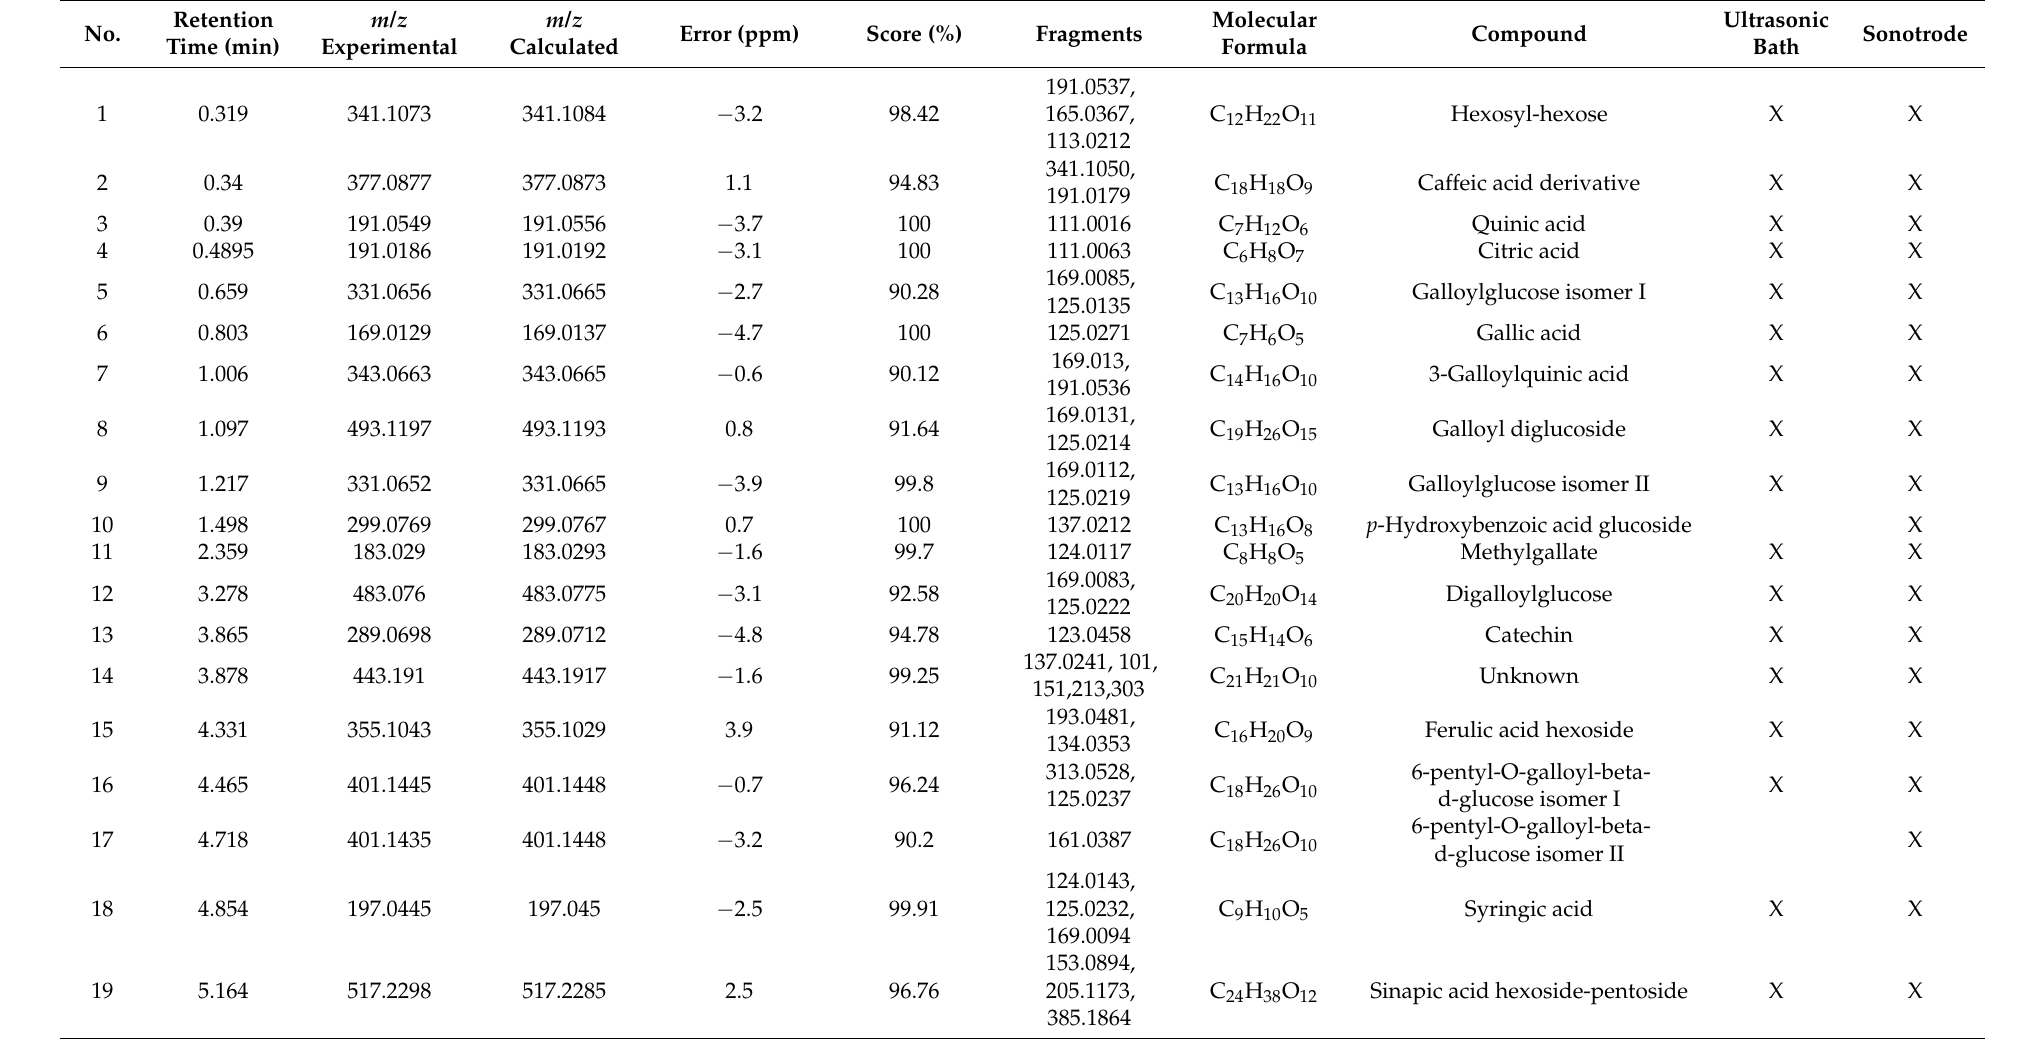
Table 5. Identified compounds from optimum ultrasonic bath and sonotrode mango peel byproduct samples using